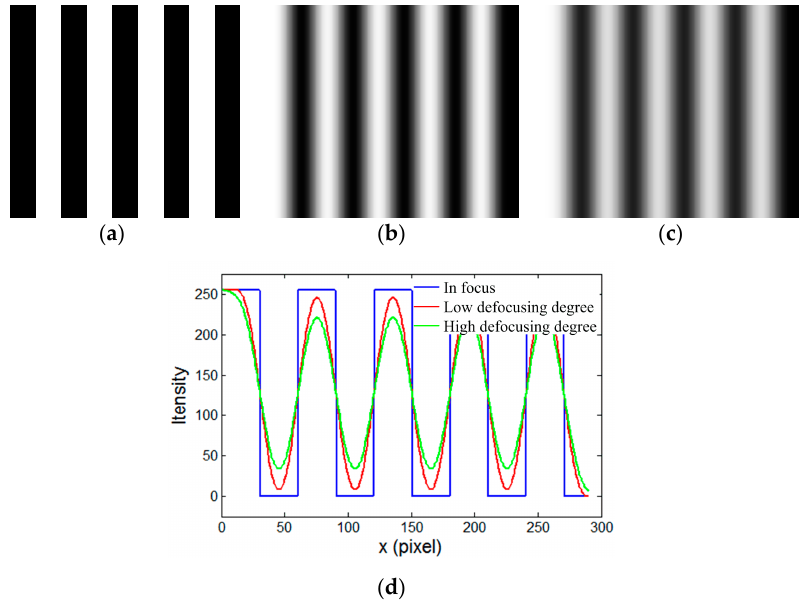
Figure 4. Simulation of the binary defocusing technique. ( a ) Binary structured pattern; ( b ) sinusoidal fringe pattern with low defocusing degree; ( c ) sinusoidal fringe pattern with high defocusing degree; and, ( d ) cross-section.